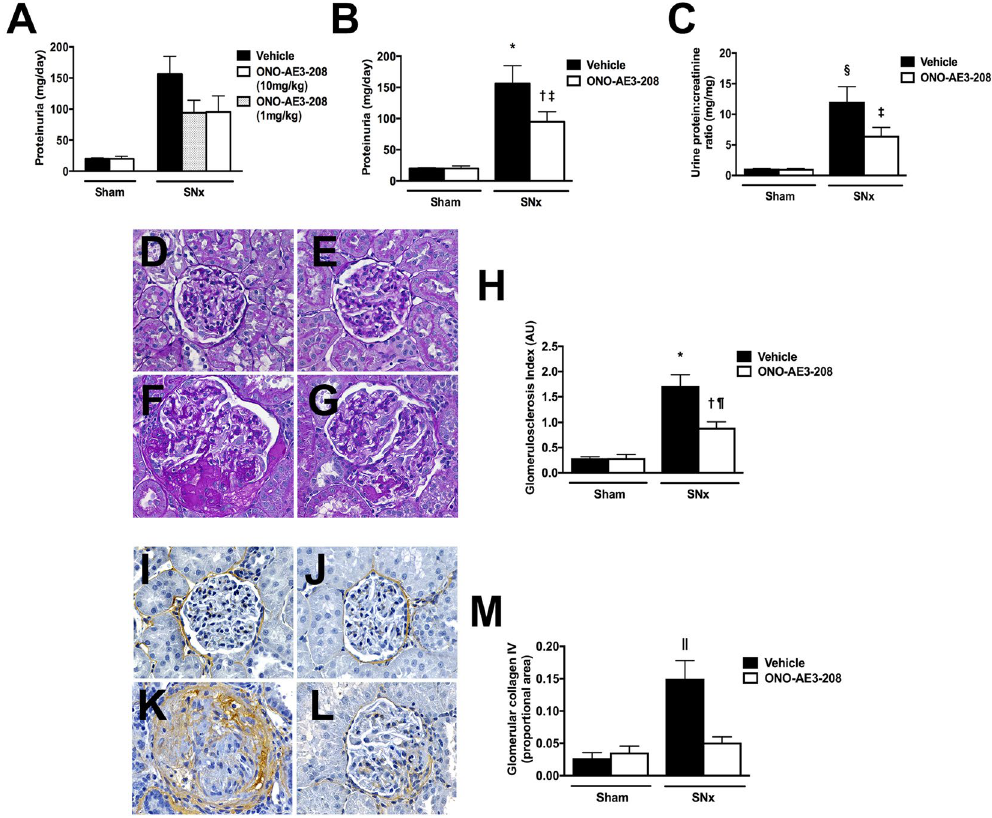
Figure 4. Urine protein excretion and glomerular injury in sham and subtotally nephrectomized (SNx) rats treated with vehicle (drinking water) or ONO-AE3-208 for seven weeks. Sham + vehicle n = 12, sham + ONO-AE3-208 n = 12, SNx + vehicle n = 18, SNx + ONO-AE3-208 (1 mg/kg/day) n = 8, SNx + ONO-AE3-208 (10 mg/kg/day) n = 8. ( A ) Increased 24 hour urine protein excretion in SNx rats and an equivalent reduction with either 1 mg/kg/day or 10 mg/kg/day ONO-AE3-208. Because of this equivalent reduction, the two groups of ONO-AE3-208-treated SNx rats were subsequently combined in further analyses. ( B ) 24 hour urine protein excretion. (C) Urine protein:creatinine ratio. ( D – G ) Representative photomicrographs of periodic acid-Schiff stained kidney sections from ( D ) sham + vehicle, ( E ) sham + ONO-AE3-208, ( F ) SNx + vehicle, ( G ) SNx + ONO-AE3-208. Original magnification × 400. ( H ) Glomerulosclerosis index. ( I – L ) Representative photomicrographs of collagen IV immunostained kidney sections from ( I ) sham + vehicle, ( J ) sham + ONO-AE3-208, ( K ) SNx + vehicle, ( L ) SNx + ONO-AE3-208. Original magnification × 400. ( M ) Proportional glomerular area positively immunostaining for collagen IV. AU = arbitrary units. * p < 0.0001 vs. sham + vehicle or sham + ONO-AE3-208; † p < 0.05 vs. sham + vehicle or sham + ONO-AE3-208; ‡ p < 0.05 vs. SNx + vehicle; § p < 0.001 vs. sham + vehicle or sham + ONO-AE3-208; ¶ p < 0.001 vs. SNx + vehicle, || p < 0.0001 vs. all other